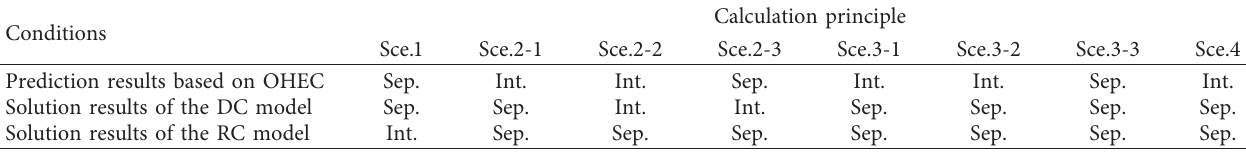
Table 4: Comparison of the utility calculation principle for different scenarios under deterministic and risky conditions.